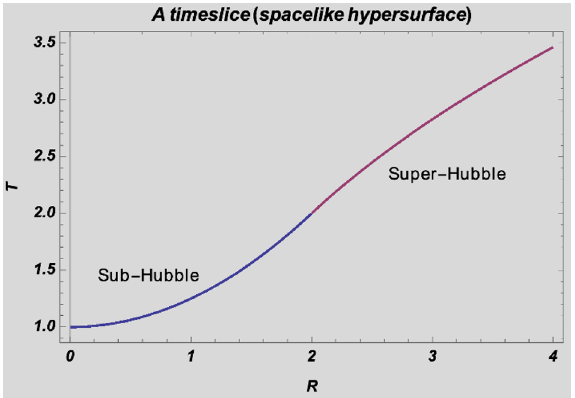
Figure 3 . A constant cosmic time ( η = η 0 ) slice in the ( T, R ) plane (the depicted slice has p η 0 = 2 / H e ). In the sub-Hubble region it consists of the lower portion (with respect to the SLR) of the parabola (4.7) (showed by the blue curve), while in the super-Hubble region is foliated by the parabola (4.8) (only the portion right to the SLR — showed by the purple curve). They intersect at the Hubble radius at T = R where (4.7) and (4.8) are identical. This is an example of a